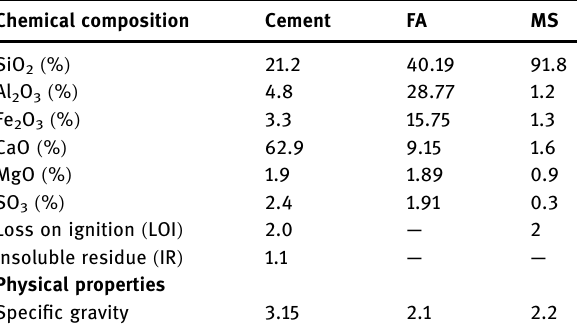
Table 2: Chemical and physical properties of binder materials Chemical